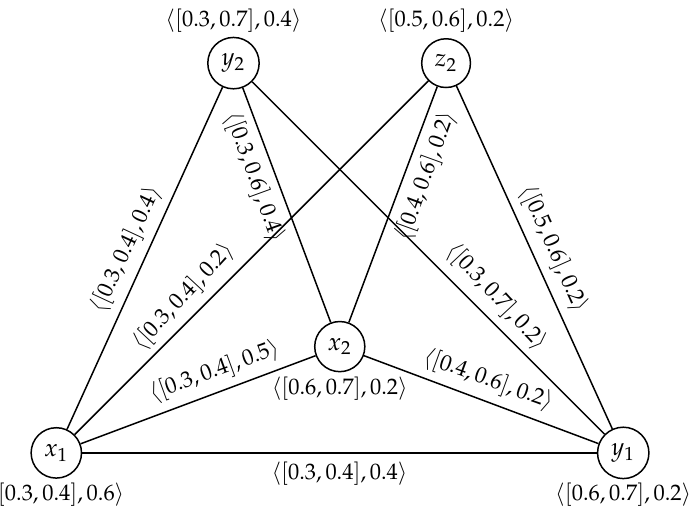
Figure 4. The joining of G 1 and G 2